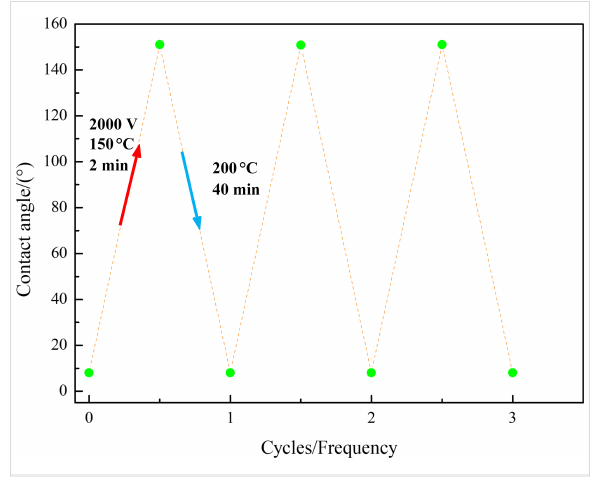
Figure 12: Durability of reversible conversion of coating superhy-